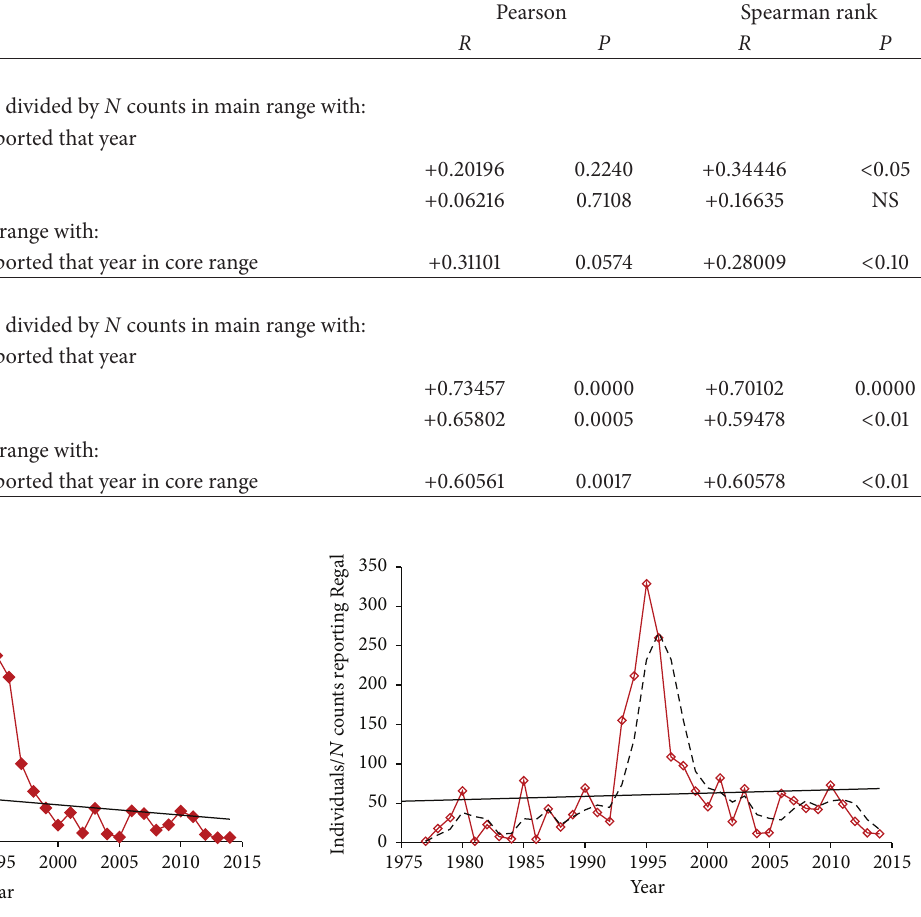
Figure 7: Total Regal Fritillary individuals per total party-hours reported in core range each year, with regression trend line. This decline was far from significant in 1977–2014 but was significant in 1991–2014 (Table 3).